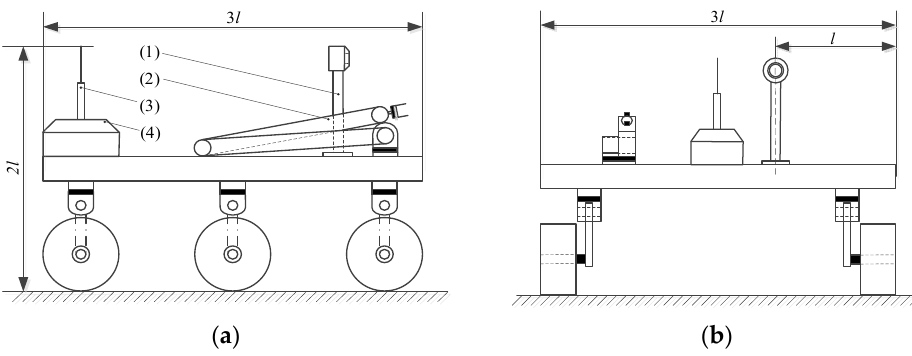
Figure 1. Structure model of the lunar rover. It carries (1) the front camera, (2) the vehicle-mounted manipulator, (3) the signal receiver, (4) the system controller. ( a ) The left view. ( b ) The main view. Table 1. Key symbols and abbreviations in Section 2. Symbol or Acronym Paraphrase